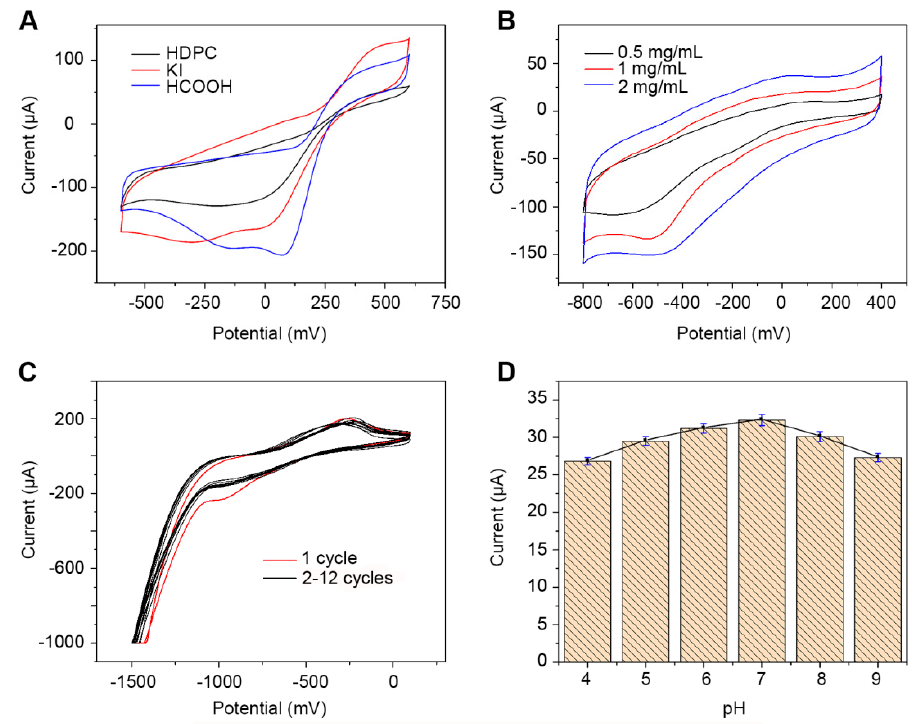
Figure 4. Optimization of experimental conditions used in the generation of the CA242 immunosensor. ( A ) Cyclic voltammograms of the sensor synthesized by di ff erent reductants. ( B ) Cyclic voltammograms of the sensor generated by di ff erent concentrations of the material. ( C ) Cyclic voltammograms of the sensor generated by di ff erent reduction cycles in N 2 -saturated PBS. ( D ) Response currents of the sensor measured at various pH values.